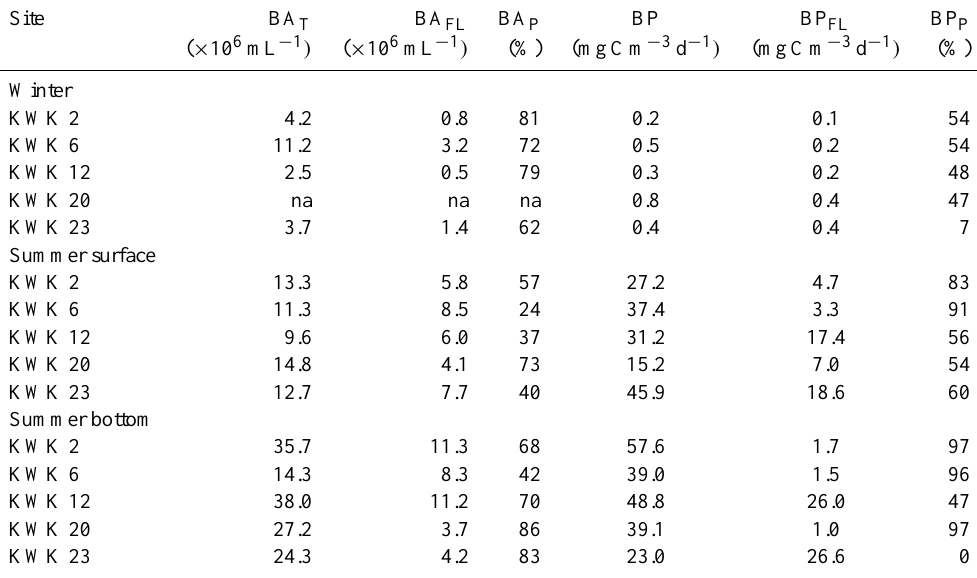
Table A1. Particle attachment of bacterioplankton in winter, summer at the surface and bottom of ponds, including sonicated bacterial abun- dance (BA T ) representing the total abundance, bacterial abundance before sonication (BA FL ) representing free-living bacteria, proportion of particle-attached bacteria (BA P ) , total bacterial production (BP; as in Table 3), filtered (3µm) bacterial production (BP FL ) and proportion of particle attached bacterial production (BP P )